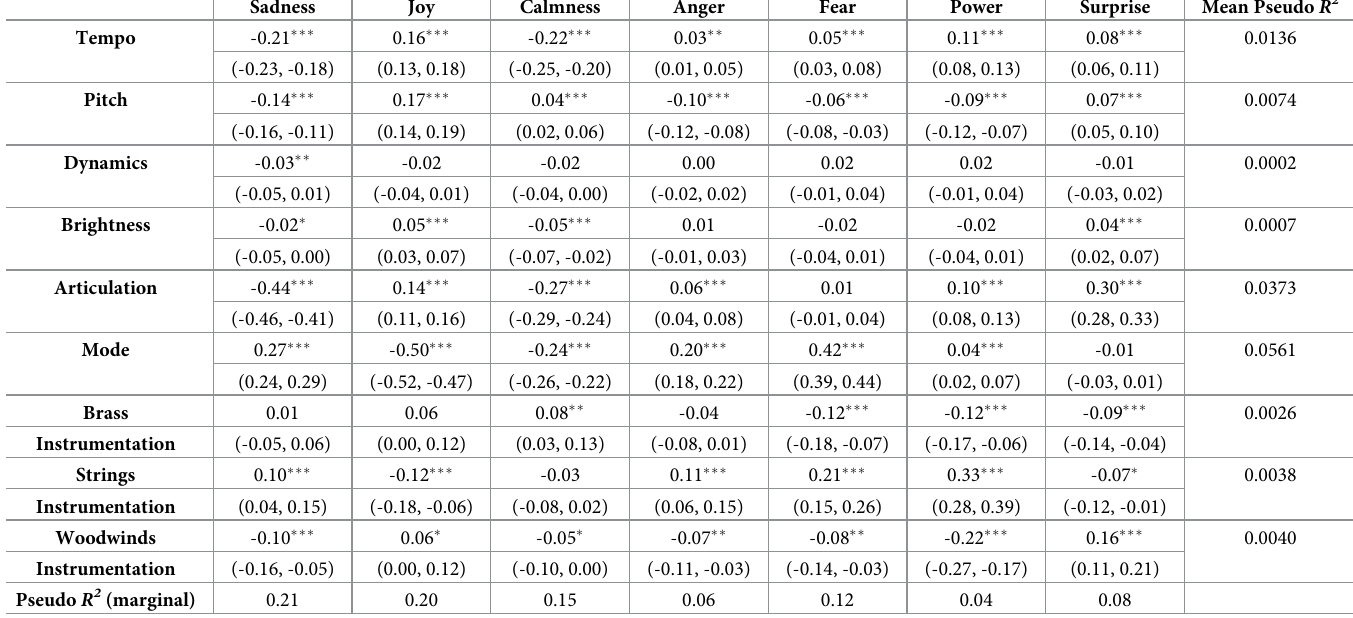
Table 3. Linear Mixed Model (LMM) results for seven emotions across all cues in the perception experiment. The numbers are standardised betas, and their 2.5% and 97.5% confidence intervals are denoted in brackets.